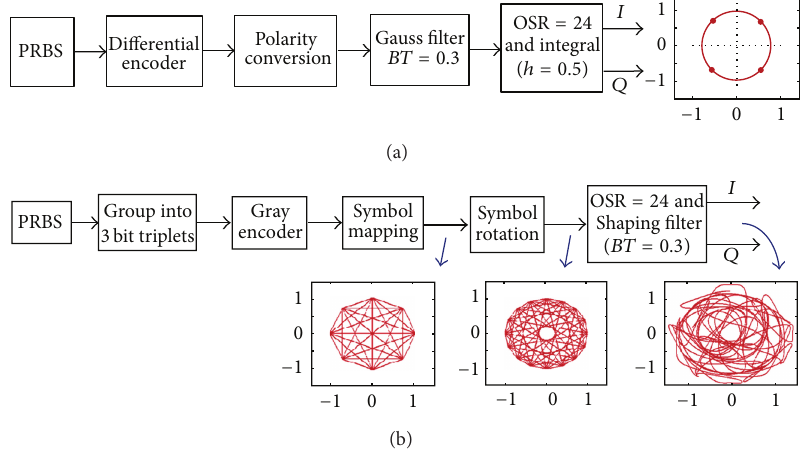
Figure 4: Block diagram of baseband 𝐼/𝑄 signal generation: (a) GMSK for GSM and (b) 8PSK for EDGE.